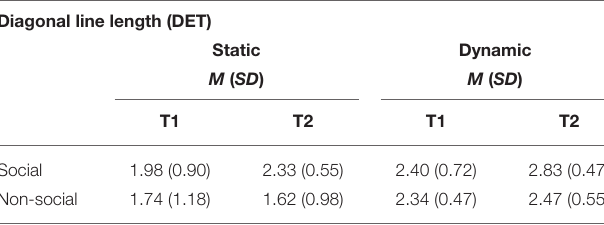
TABLE 1 | Mean and standard deviations for diagonal line lengths in static and dynamic displays at T1 and T2. Diagonal line length